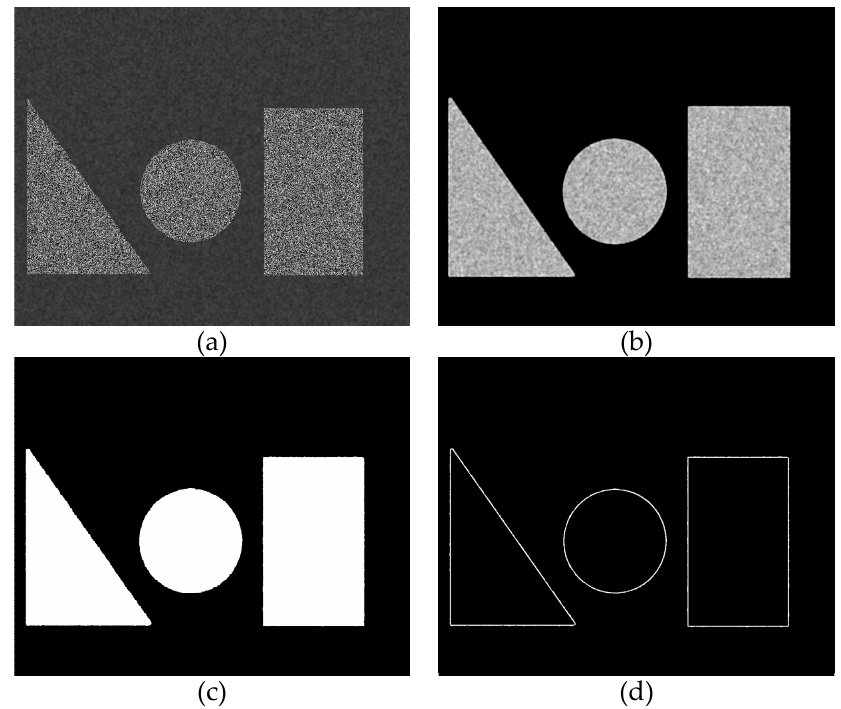
Figure 7. Simulation of the proposed background segmentation method. ( a ) Simulative image; ( b ) σ value map; ( c ) segmentation result; and ( d ) segmentation errors.